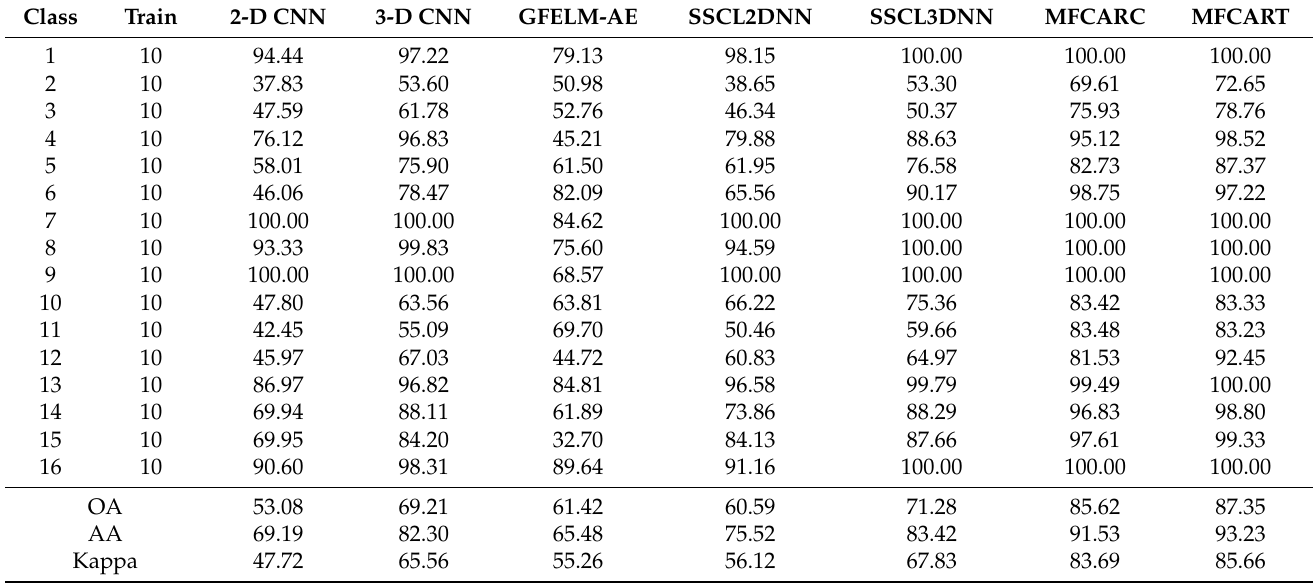
Table 10. Classification performance of different methods over the Indian Pines data